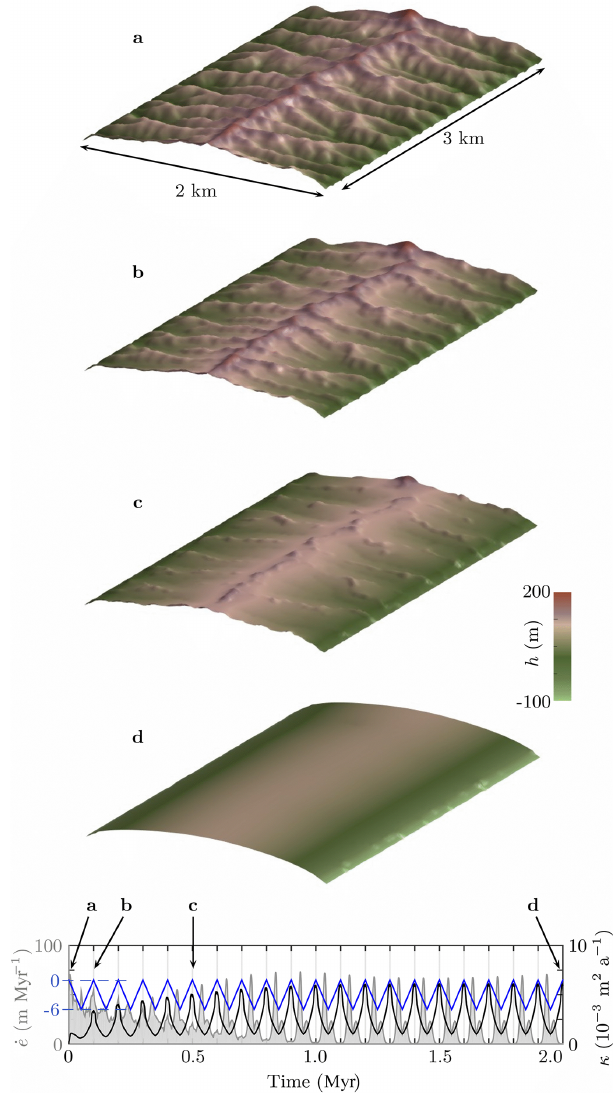
Figure 4. Computational experiment (no. 1) with periglacial ero- sion of a synthetic, fluvial-style initial landscape. The experiment shows the development of a single summit flat. The model land- scape is exposed to 20 recurrent climate cycles of 100kyr each, en- tailing saw-tooth variations in temperature. Panel (a) : initial fluvial- style topography. Panels (b–d) : predicted topography after 0.1, 0.5 and 2Myr, respectively. Bottom panel time series show temperature (blue), average erosion rate (grey), and average frost-creep diffusiv- ity